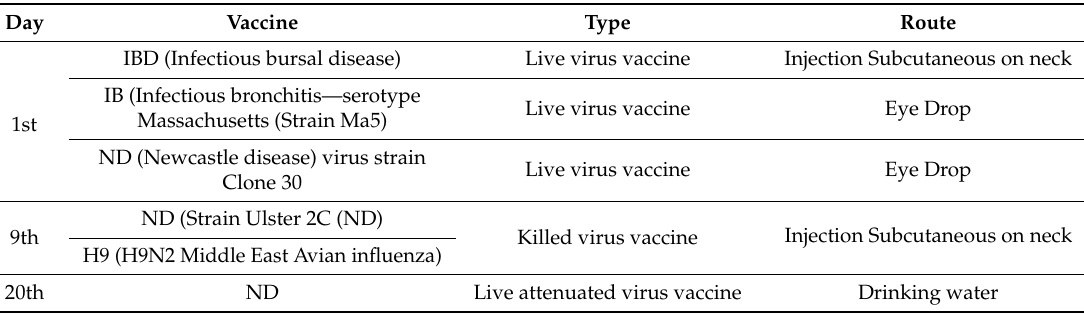
Table 2. Vaccination schedule